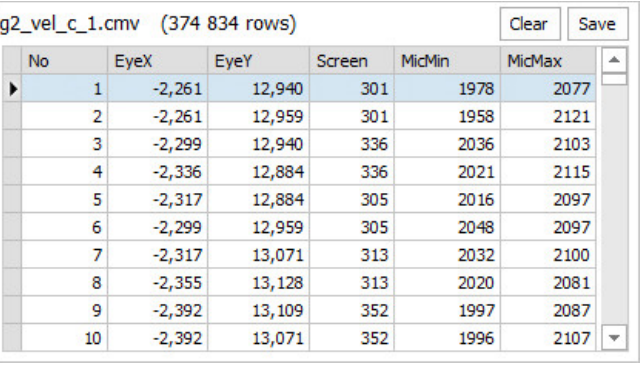
Figure 6. Converted and combined data generated by the microphone and saccade sensor.